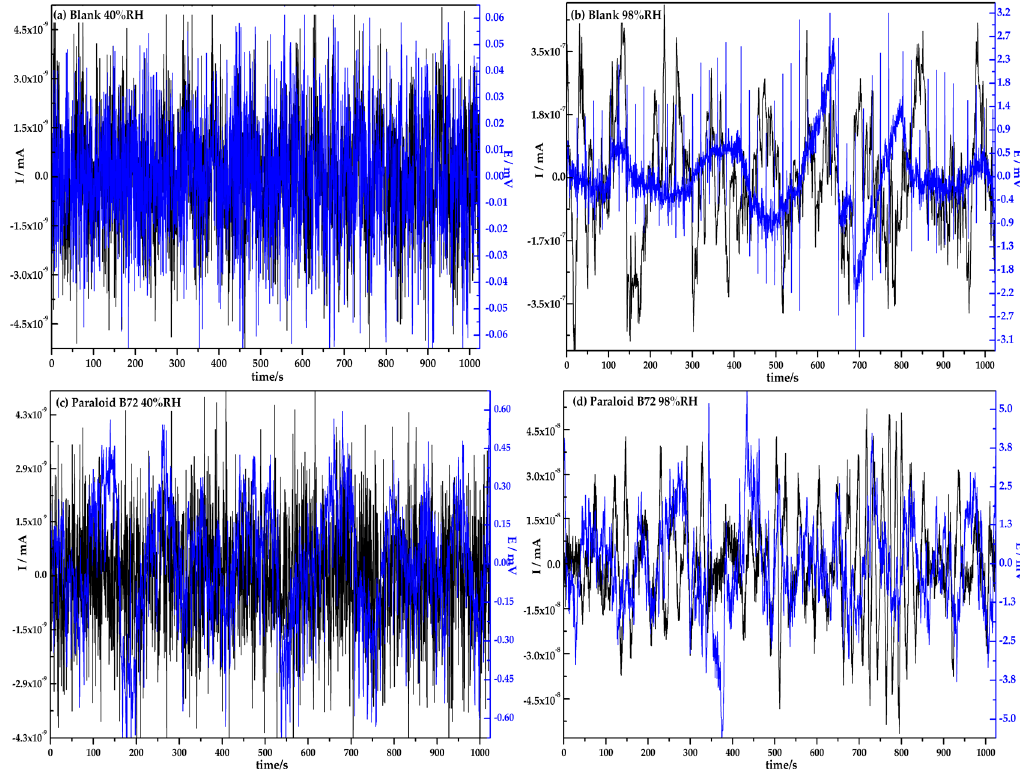
Figure 4. Cast iron’s time series in current and potential for ( a ) blank at 40% RH, ( b ) blank at 98% RH, ( c ) Paraloid B72 at 40% RH, and ( d ) Paraloid B72 at 98% RH.